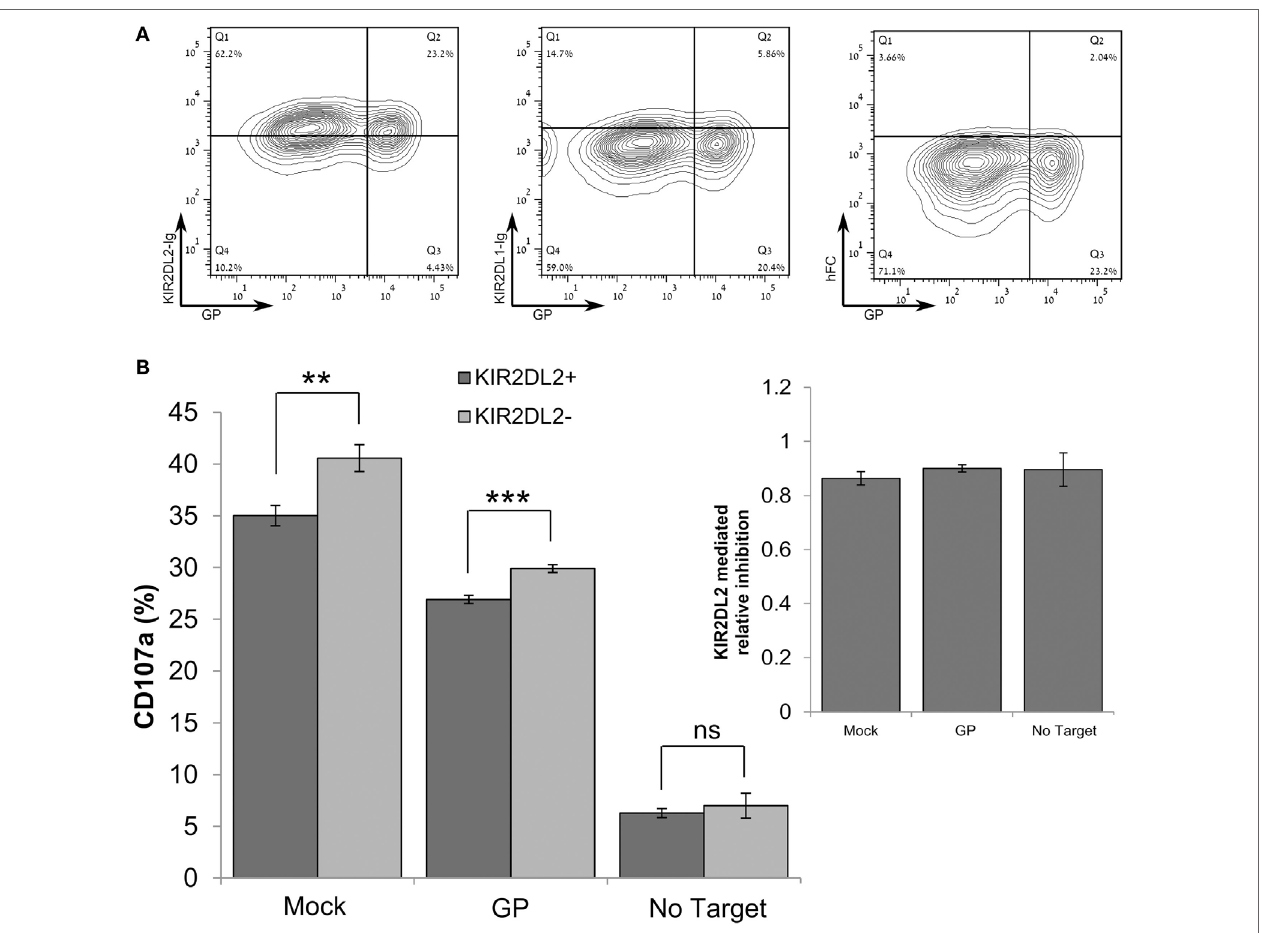
FigUre 6 | Sudan virus (SUDV)-GP-induced disruption of surface antigens does not affect KIR2DL2-mediated inhibitory pathway. In these experiments, HEK293T cells were SUDV-GP-transfected, mock transfected, or left untransfected. (a) SUDV-GP-transfected HEK293T cells were stained for SUDV-GP and co-stained for KIR2DL2 or KIR2DL1 ligands using KIR2DL2-Ig or KIR2DL1-Ig chimeric proteins, followed by PE-labeled secondary antibody. Background staining was determined by staining with purified human FC. (B) Target cells were cocultured with pNK cells in the presence of 25 U/ml rhIL-2. Target and effector cells were cocultured at an E:T ratio of 1:3 for 6 h. Cells were then harvested and analyzed for degranulation by flow cytometry. Dead cells were excluded by 7-aminoactinomycin D; pNK cells were then gated by staining for CD16 and KIR2DL2 and co-stained for degranulation with CD107a. Results are from one representative experiment of three performed. Values represent means of triplicates. Bars, ± SD. Student’s unpaired t -test; ** p < 0.01; *** p < 0.001; ns, not